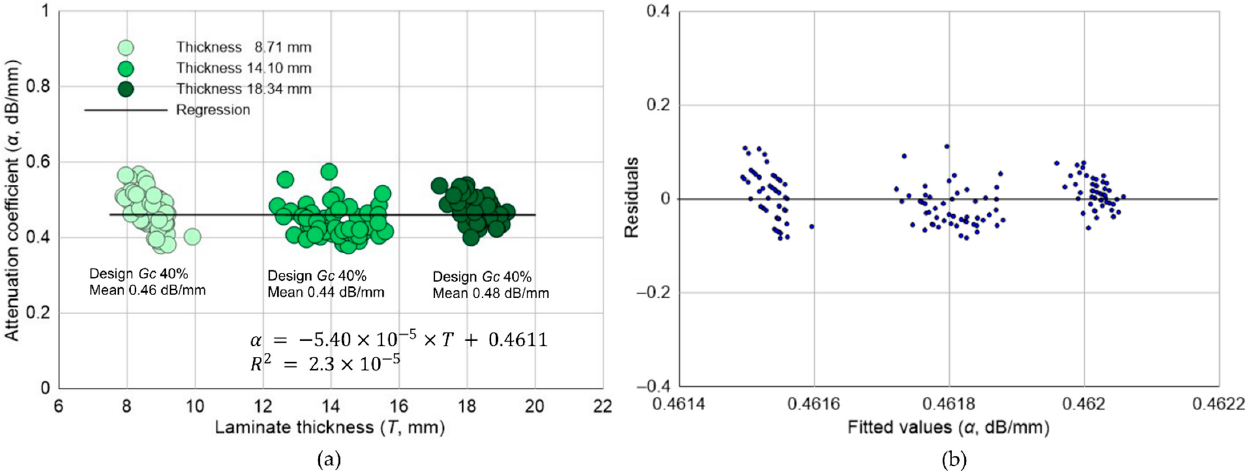
Figure 10. Ultrasonic wave attenuation coefficient as a function of the thickness. ( a ) Regression analysis results. ( b ) Residual analysis results.